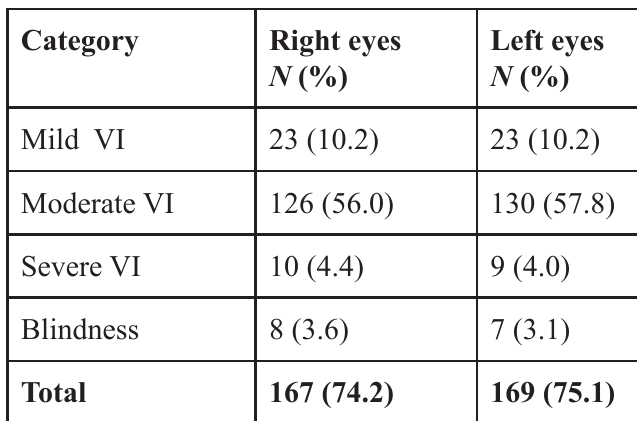
Table 1: The categories and prevalence of uncompensated visual impairment (VI) and blindness in the right and left eyes of the participants (the sample consisted of 225, but 58 and 56, in the right and left eyes respectively did not have VI and